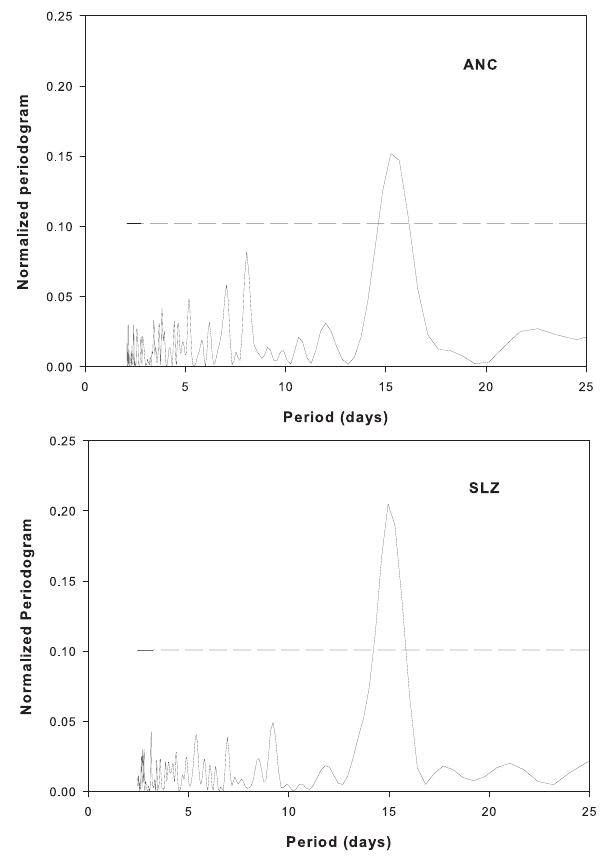
Fig. 5. Normalized periodograms for the de-trended (27-d) time series of the range of H at Ancon and Sao Luis (dashed line shows the 95% confidence